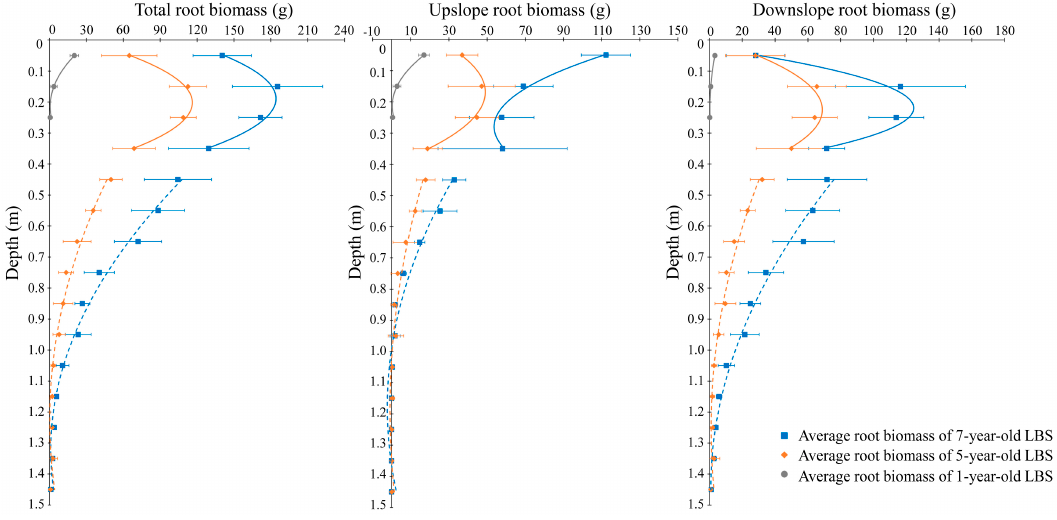
Figure 7. Average root biomass distribution with soil depth for 1, 5 and 7-year-old LBS. The fit curves of root biomass with depth by regression analysis are also shown. The solid lines represent the fitted curves of the active layers. The dotted lines represent the fitted curves of the stable layers.